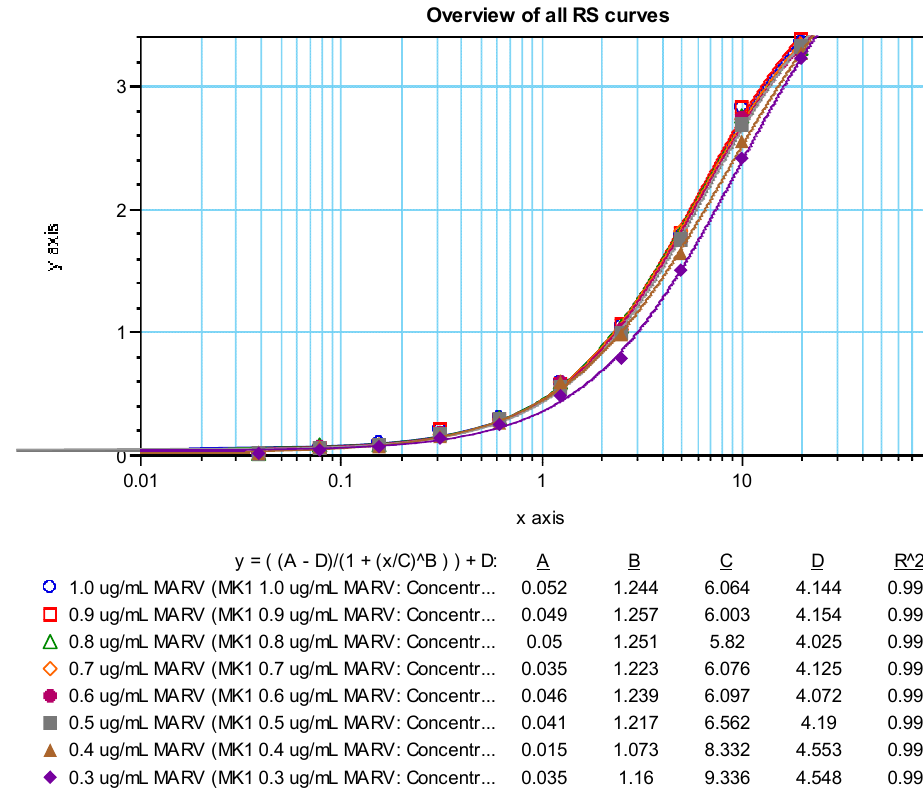
Figure 5. Coating Antigen Optimization 4PL Curve Fits—SUDV.